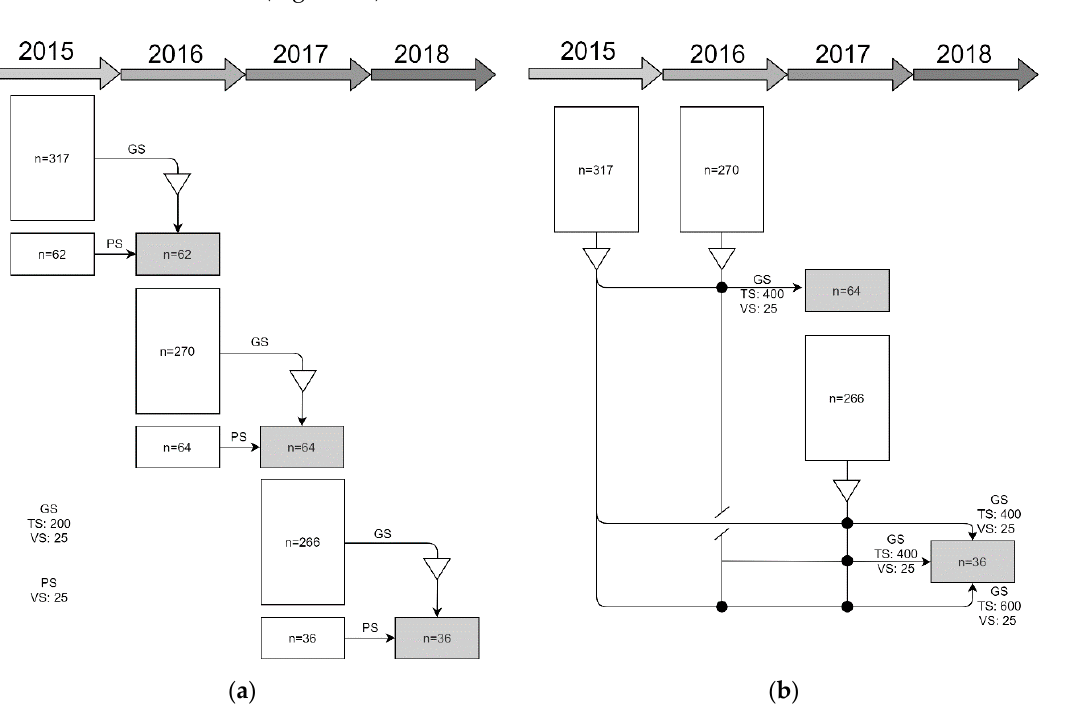
Figure 1. Validation schemes followed in this study. Single trial validation ( a ) and combined trials validation ( b ). Triangles point to sampling steps at each validation run. Filled circles reflect the merge of sampled lines from different trials. GS stands for Genomic Selection model, PS for Phenotypic Selection, TS for Training Set, and VS for Validation Set.